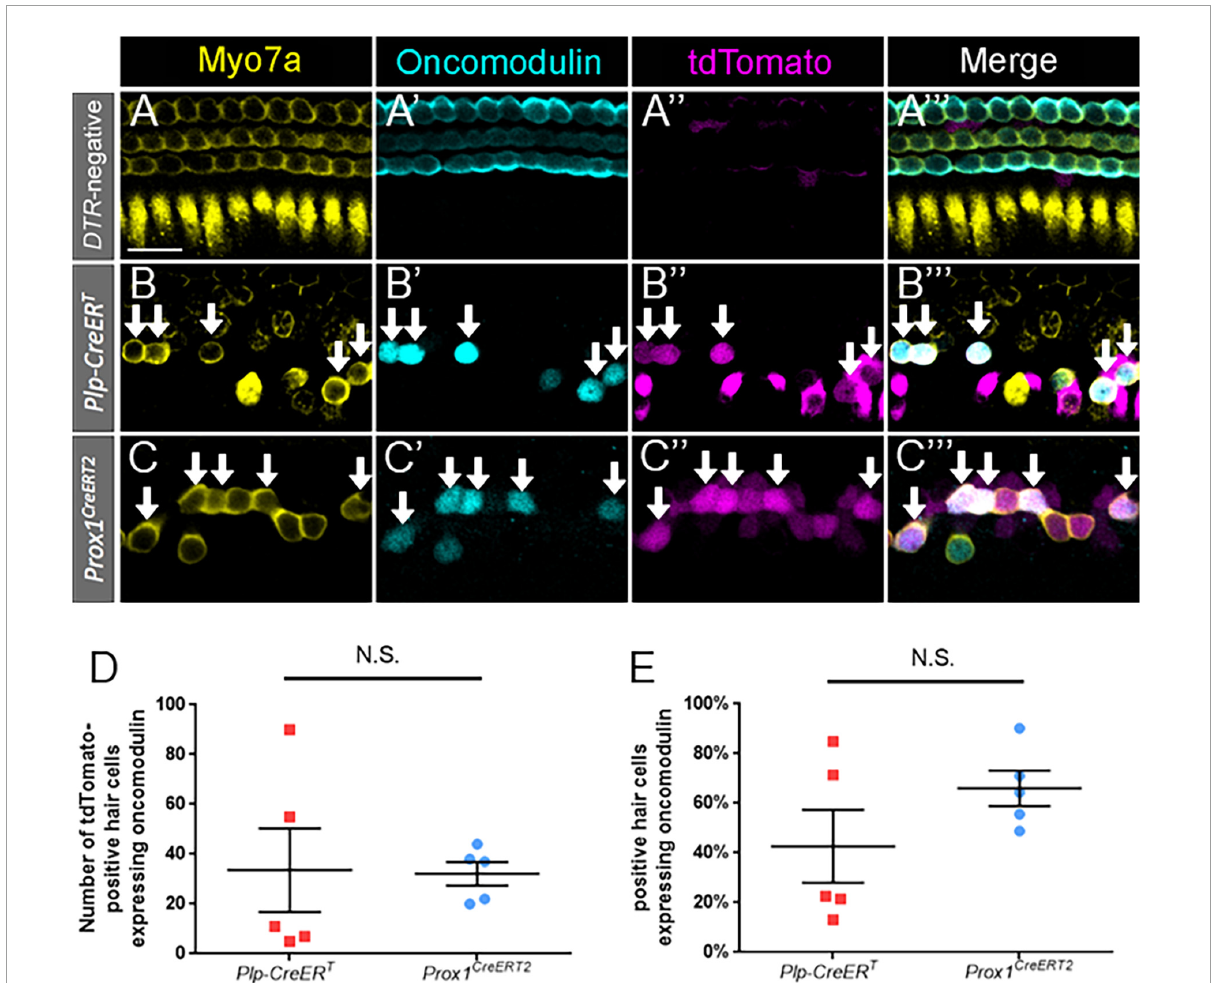
FIGURE3 Oncomodulin is expressed in a similar number and percentage of regenerated hair cells across supporting cell subtypes. (A–C”’) Representative confocal slice images from the middle turn of Pou4f3 DTR -negative (A–A”’) and apical turns of Plp-CreER T :Rosa26 tdTomato :Pou4f3 DTR (B–B”’) and Prox1 CreERT 2 :Rosa26 tdTomato :Pou4f3 DTR (C–C”’) mice at P7–P8 that were injected with tamoxifen at P0 to induce tdTomato expression in the two supporting cell subpopulations and with DT at P1 to induce hair cell damage. Samples were immunostained with anti-Myo7a antibodies (yellow) to label all hair cells and anti-oncomodulin antibodies (blue) to label immature outer hair cells. tdTomato was detected using endogenous fluorescence (magenta). Arrows indicate Myo7a-positive/oncomodulin-positive/tdTomato-positive cells that are regenerated, fate-mapped outer hair cells. Scale bar: 25 µ m. (D) There was no significant difference in the total number of regenerated hair cells expressing oncomodulin between the supporting cell populations targeted by the two CreER lines. (E) When normalized to the total number of tdTomato-positive/Myo7a-positive cells, there was no significant difference in the percentage of oncomodulin-positive regenerated hair cells between the supporting cell populations targeted by the two CreER lines. Significance was determined using an unpaired Student’s t -test. Data are presented as mean ± SEM; n = 5. N.S., not